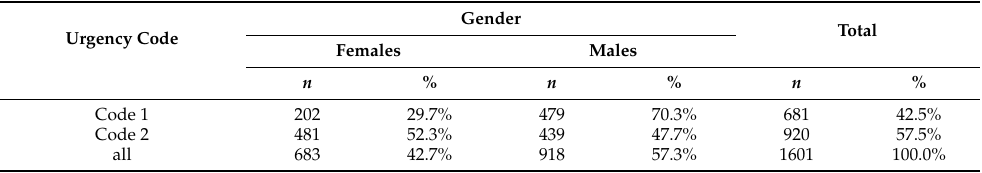
Figure 1. Interventions of emergency medical services teams in the workplace depending on the urgency code and gender.